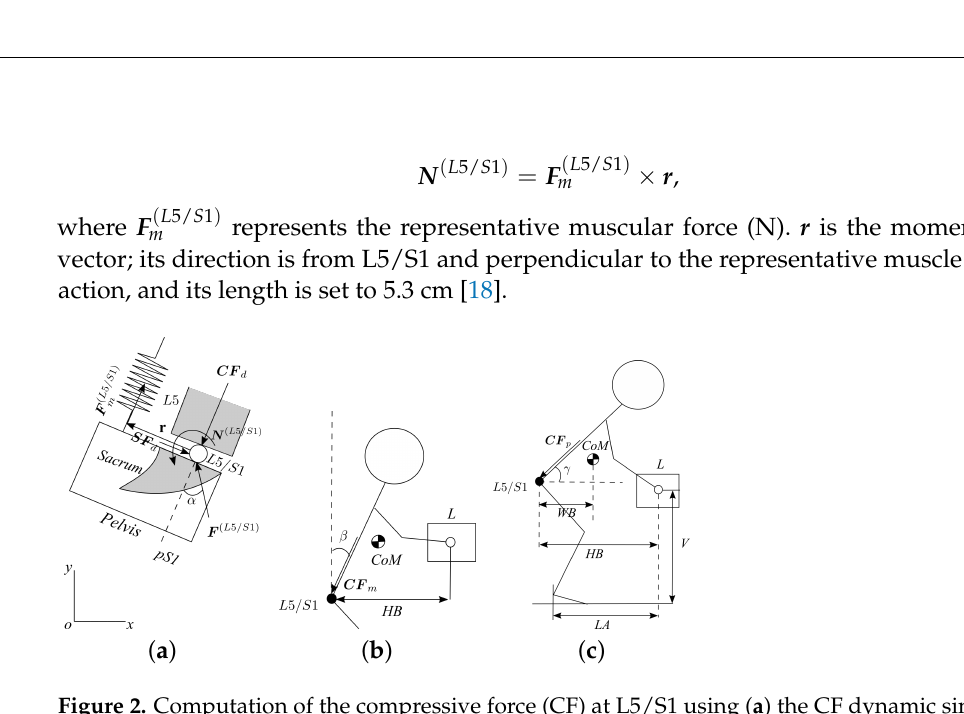
Figure 2. Computation of the compressive force (CF) at L5/S1 using ( a ) the CF dynamic simulator ( N ( L 5/ S 1 ) and F ( L 5/ S 1 ) are first obtained by inverse dynamic calculations), ( b ) Merryweather’s model [16], and ( c ) Potvin’s model [15]; the calculation is based on the global coordinate system